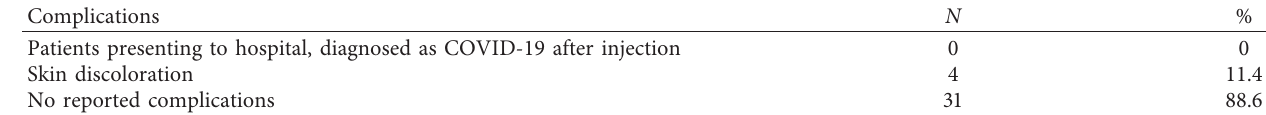
Table 4: Complications following musculoskeletal injections.